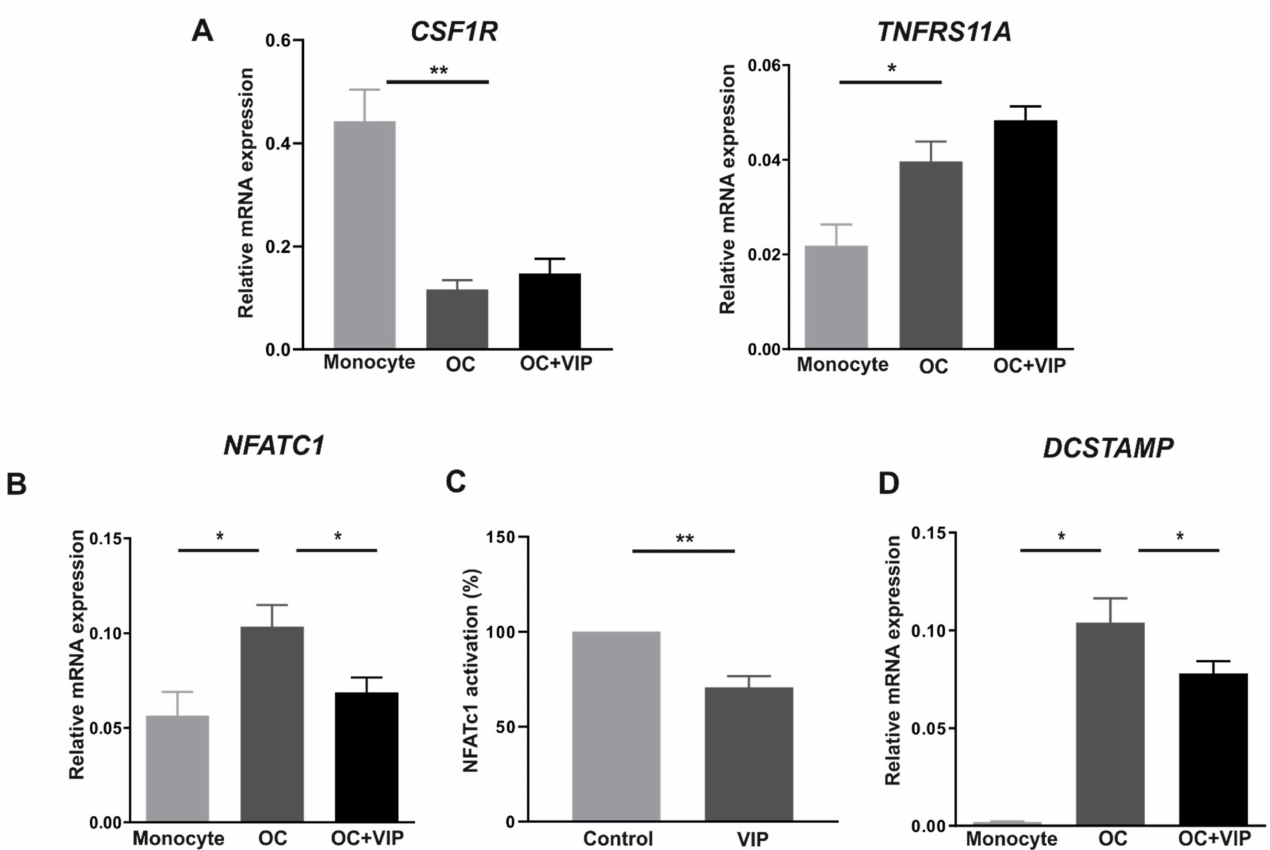
Figure 3. VIP down-regulates the expression of osteoclast-specific markers. CSF1R , TNFRS11A ( A ) and NFTAC1 ( B ) mRNA expression levels in monocytes and differentiated osteoclasts in absence (OC) or presence of VIP 10 − 8 M (OC+VIP) was determined by real-time PCR. ( C ) Activation and nuclear translocation of NFATc1 after 12 h of stimulation with 1 ng/mL RANKL (control) or RANKL and VIP 10 − 8 M (VIP). NFATc1 activation was measured in nuclear extracts by TransAM. Results were reported as a percentage increase over control stimulation. ( D ) DCSTAMP mRNA expression in monocytes and differentiated osteoclasts in absence (OC) or presence of VIP 10 − 8 M (OC+VIP). Real-time PCR results are expressed as relative mRNA expression (relative to GAPDH levels). The means ± SEM of triplicate determinations of 6 independent experiments are shown. Mann–Whitney U test and Kruskal–Wallis using Dunn’s post hoc test was performed (* p < 0.05; ** p <